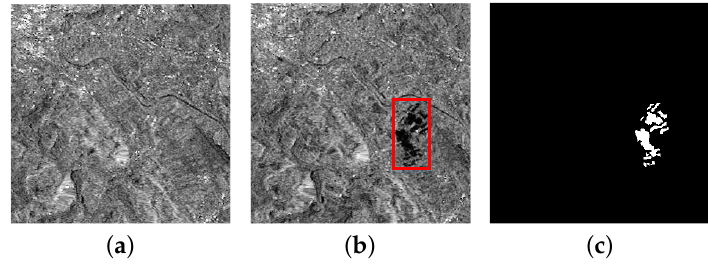
Figure A1. Multi-temporal SAR images relating to the region on Bern. ( a ) Image acquired in April 1999. ( b ) Image acquired in May 1999. ( c ) Reference